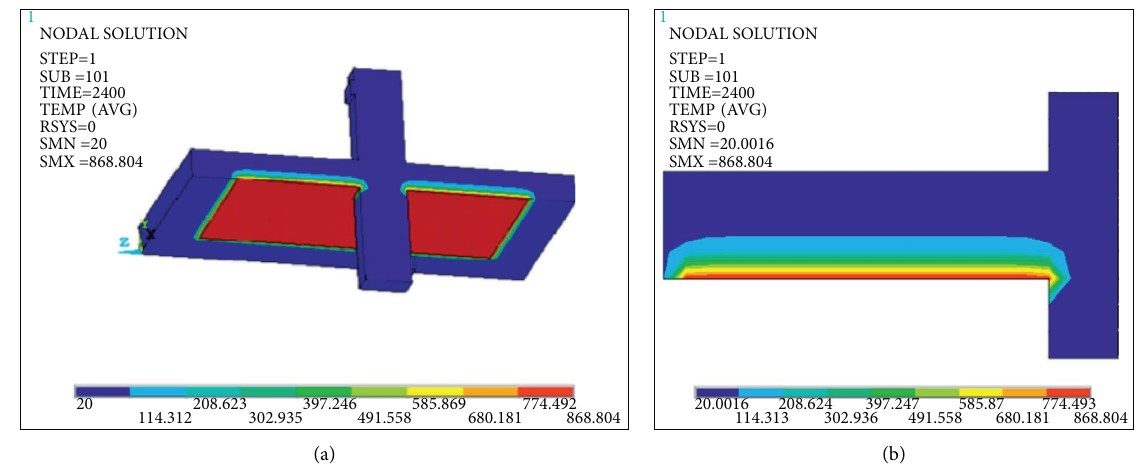
Figure 30: Nodal temperature distribution of control specimen with 2400sec fre exposure at the bottom surface of slab. (a) 3D view of nodal temperature distribution of the control specimen. (b) Centerline section view of nodal temperature distribution of the control specimen.